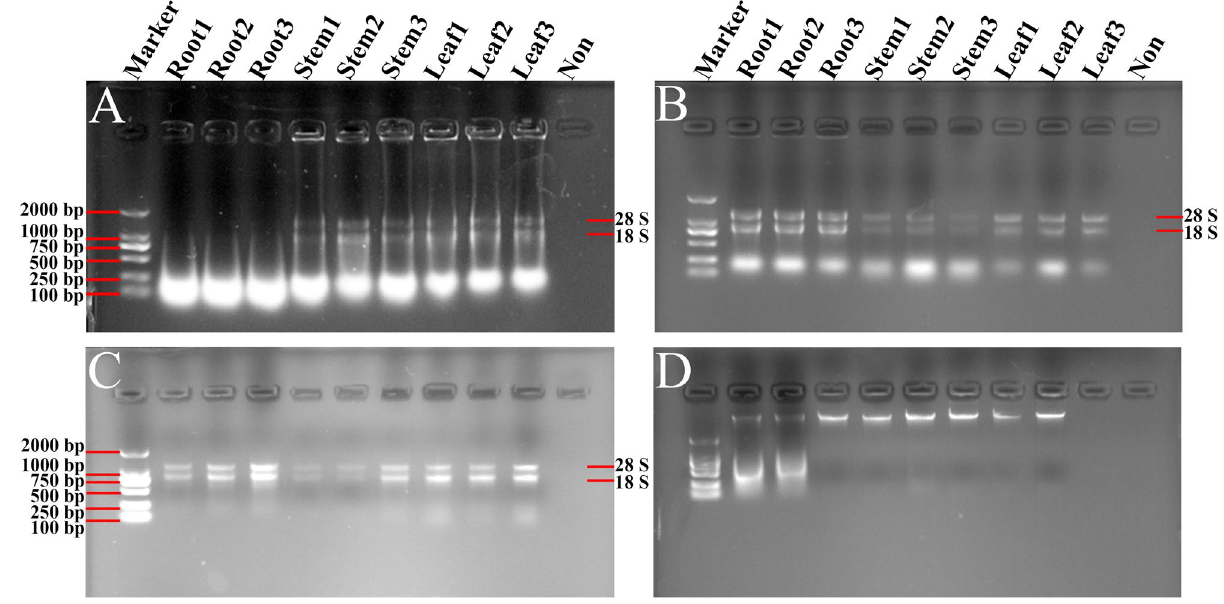
Figure 1. Gel images of total RNAs from root, stem and leaf tissues of Lilium davidii var. unicolor isolated using different protocols. The RNA samples extracted by TRIzol method ( A ), the modified TRIzol method ( B ), Kit method ( C ) and CTAB method ( D ) were separated and analyzed in 1% agarose gels, respectively. Then the gels were visualized and exposed by Gel Imager System in different fields, and pictures were taken, respectively. The order of samples in each gel lane is as follows: Lane 1: DL2000 DNA marker; Lanes 2–4 are RNA isolated from root of Lilium ; Lanes 5–7 are RNA isolated from stem of Lilium ; Lanes 8–10 are RNA isolated from leaf of Lilium ; Lane 11: Loading buffer solution without RNA to serve as a control. 28S and 18S represent the location of 28S and 18S rRNA bands.